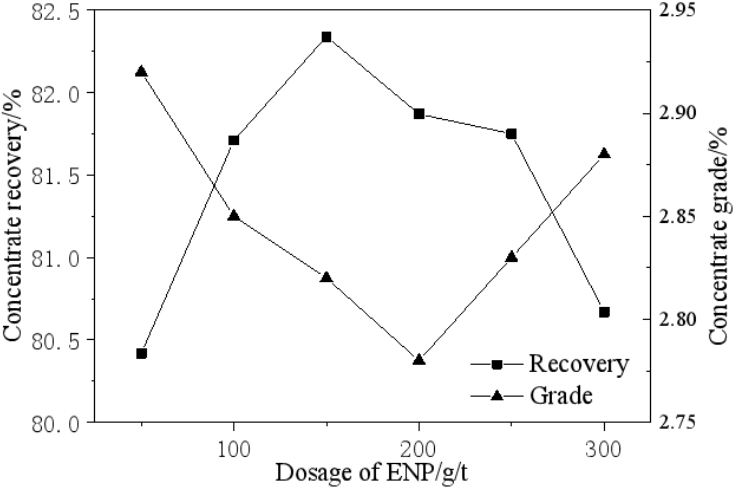
Figure 6. Influences of the ethylenediamine phosphate dosage of the copper oxide flotation index.